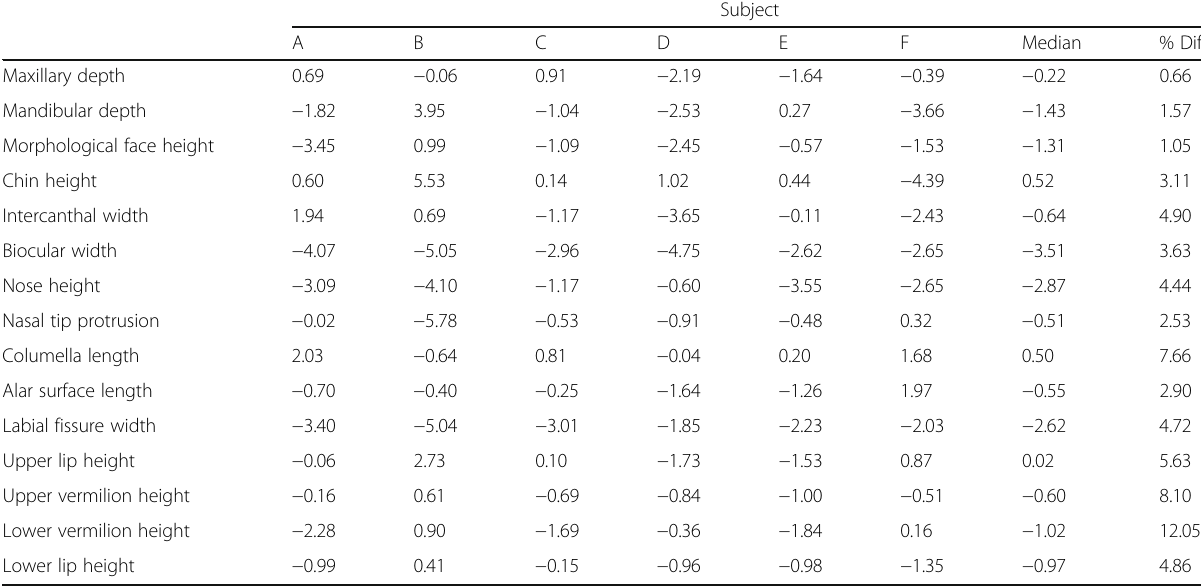
Table 4 Differences between 3D and manual